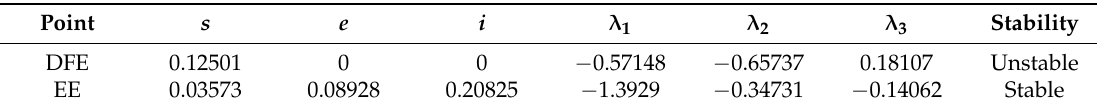
Table 7. Local Stability ( β = 4 (Epidemic)).